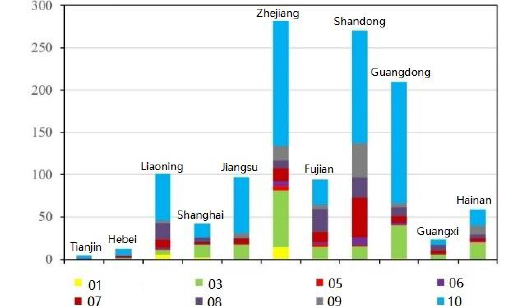
Figure 9. Statistics of coastal landscape expansion (km 2 ). The land type codes are detailed in Figure